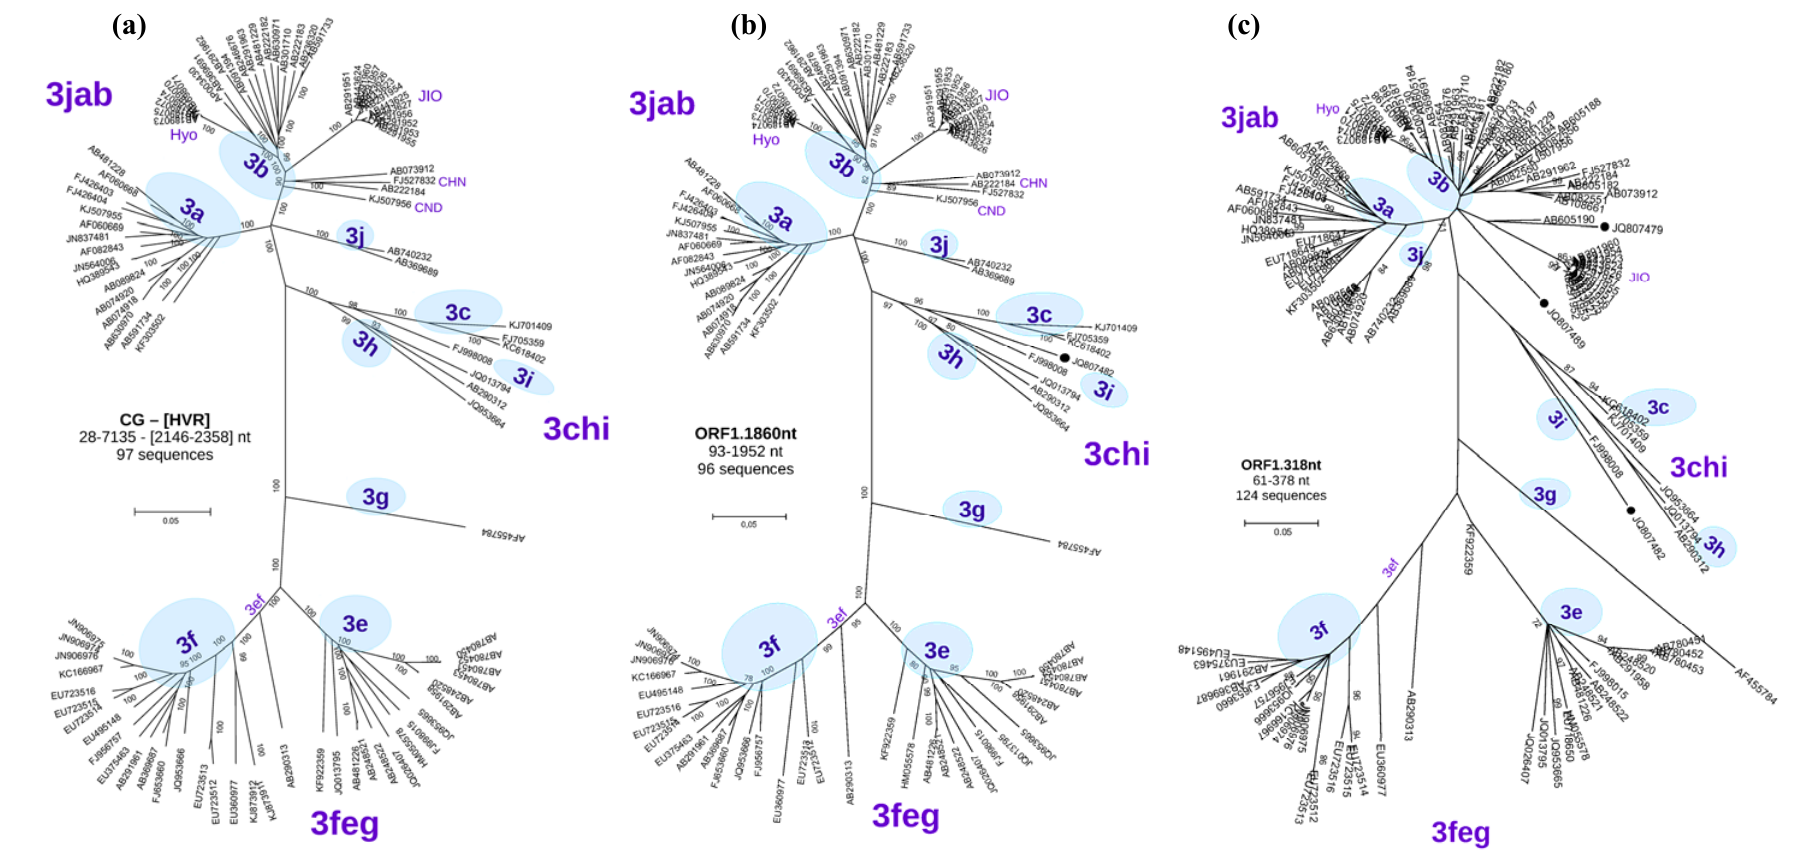
Figure 3. Molecular phylogenetic analysis of: ( a ) CG-[HVR] : 97 complete HEV-3 genomes, excluding the HVR (M73218:2146-2358 nt); ( b ) ORF1.1860nt: 96 partial HEV-3 genome sequences spanning the region 93–1952 nt, which correspond to a partial sequence JQ807482(●) obtained in this study from the animal WS05-09; ( c ) ORF1.318nt : 124 partial HEV-3 genome sequences spanning the region Burma.M73218: 61–378 nt approximately correspond to Figure 2 in [32]. Three of the sequences obtained in this study are included here (●): JQ807489, JQ807482 and JQ807479 (Bugewitz strain). Detailed view of the sequences used in b and c can be seen in supplementary Figures S01 and